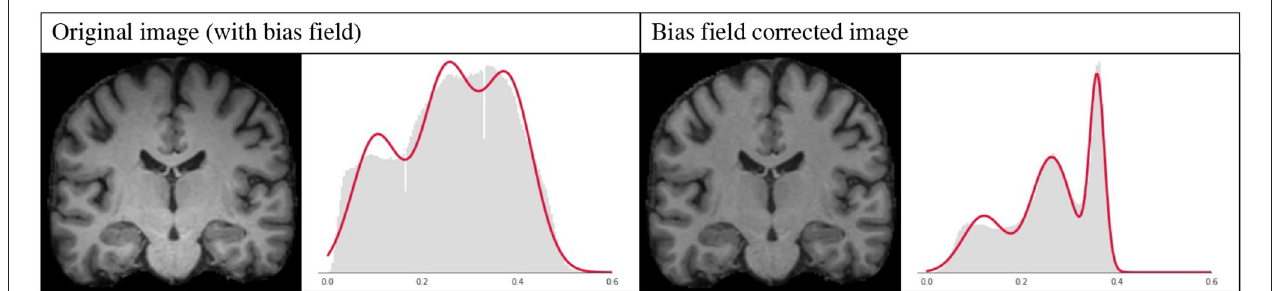
FIGURE 9 | Influence of bias field on the GMM. Images and corresponding histograms with GMM prediction overlaid in red. Left: original image with bias field; right: bias field corrected image.